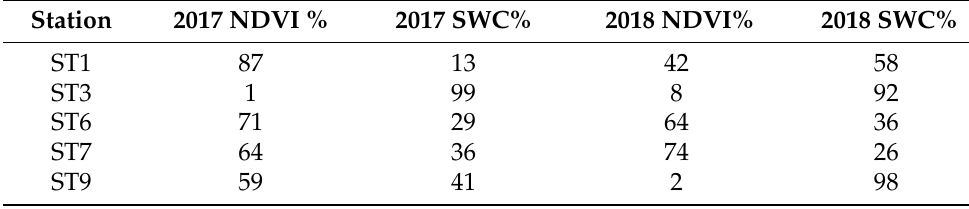
Table 5. Dominance analyses of the linear models between HV ∼ NDVI and HV ∼